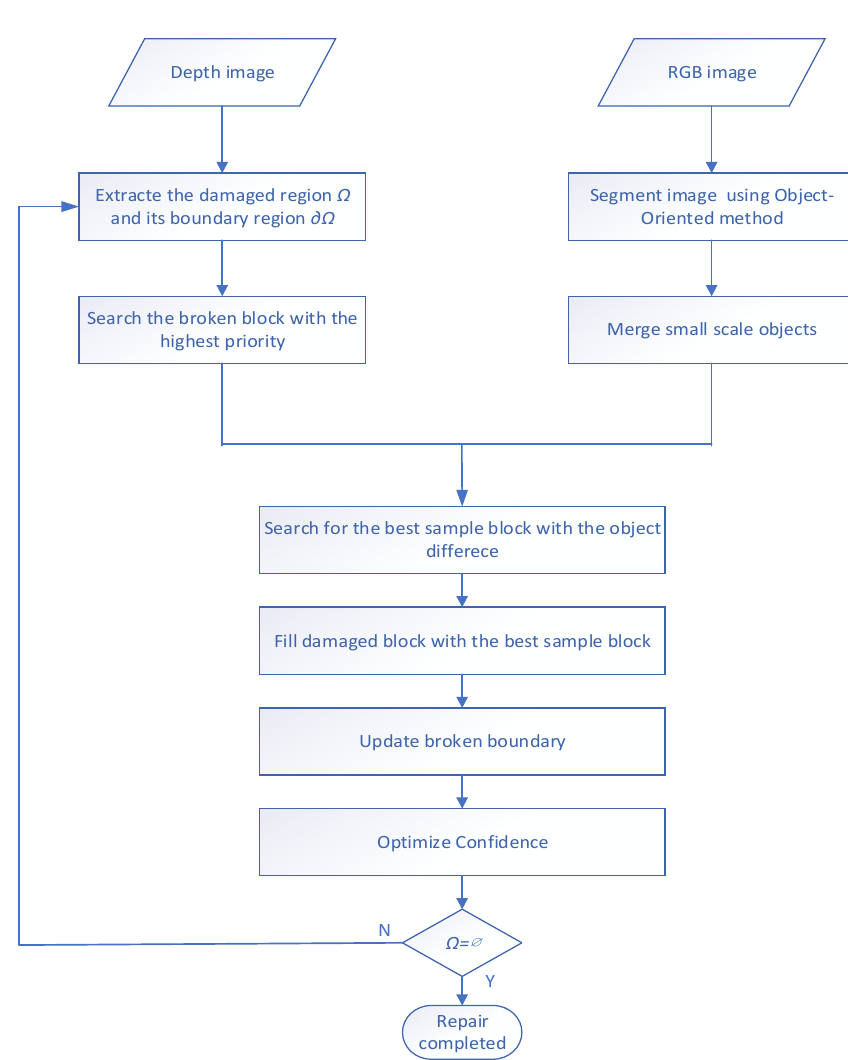
Figure 2. Flow chart of depth image texture synthesis repair.